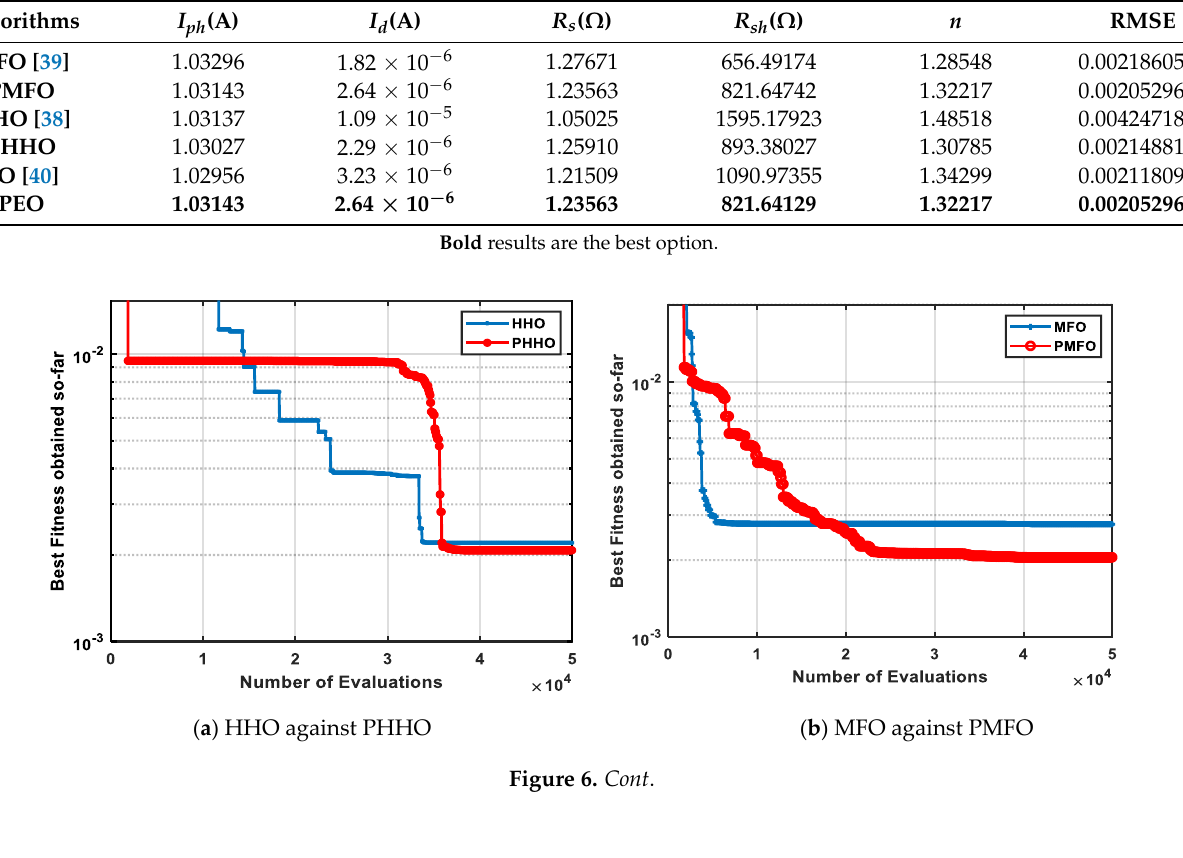
Table 6. Comparison of statistical measures of Photowatt-PWP201. Algorithms